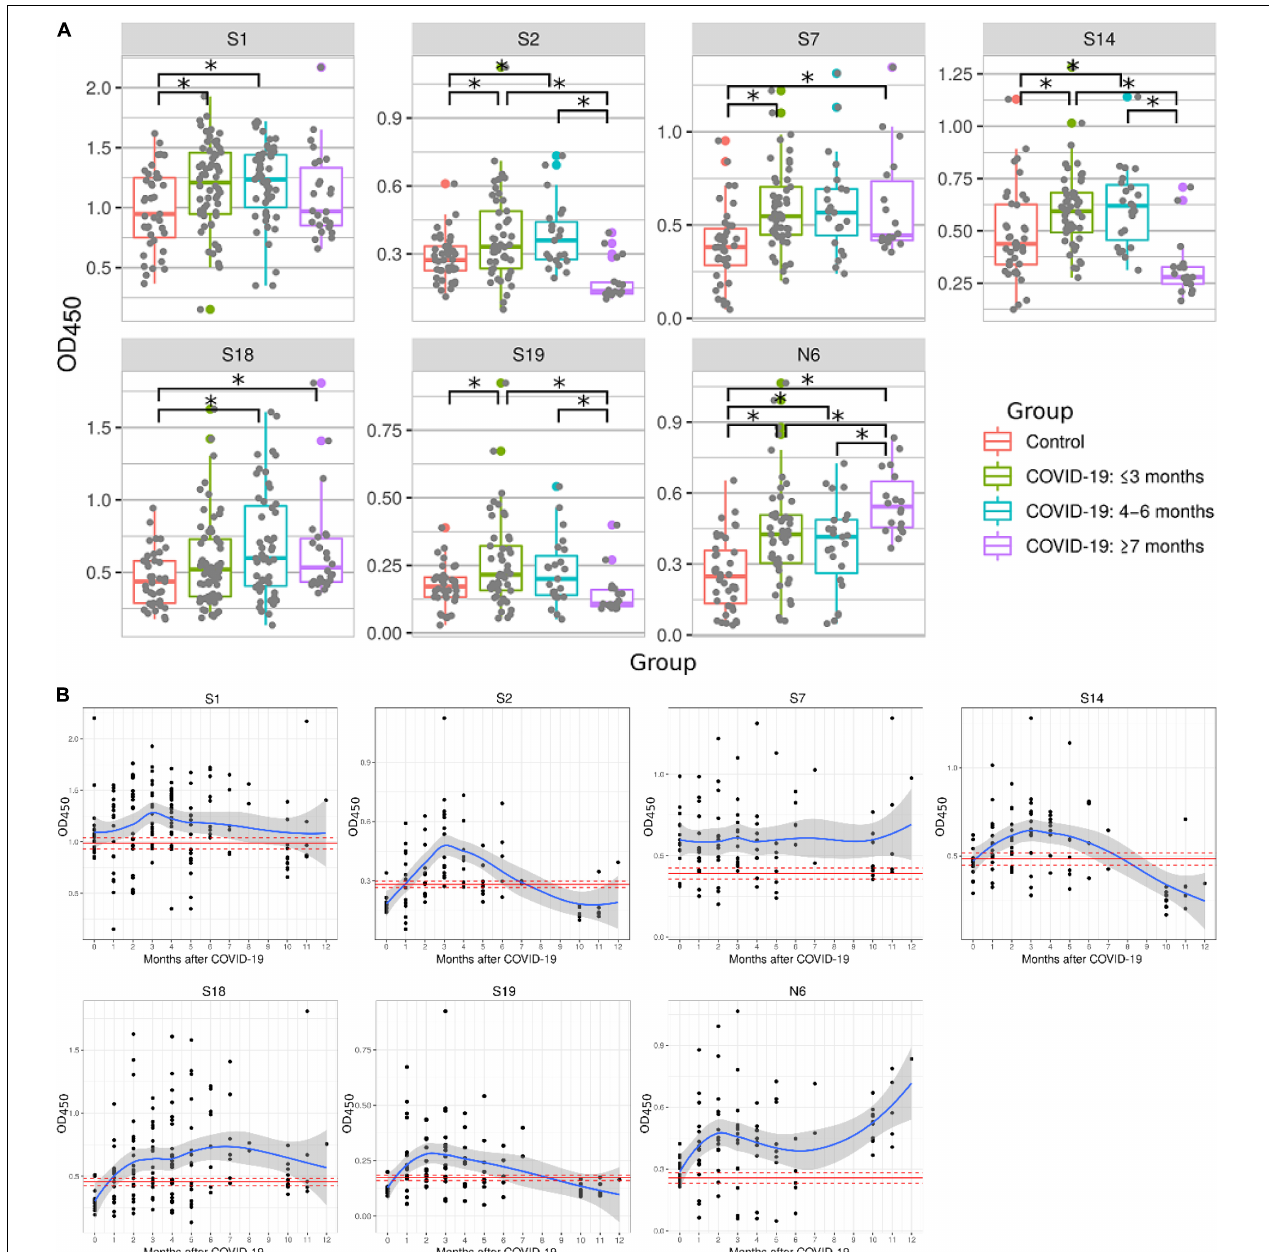
FIGURE 3 | Reactivity of COVID-19 serum samples with SARS-CoV-2 peptides depending on time after convalescence. Antibody reactivity was analyzed using ELISA. Peptides were adsorbed on a 384-well plate and probed with serum samples. (A) Reactivity to SARS-CoV-2 peptides in COVID-19 serum samples grouped as: ≤ 3 months, 4–6 months and ≥ 7 months. Asterisks indicate statistically significant differences between reactivity to SARS-CoV-2 peptides depending on time since infection ( p < 0.05, Kruskal-Wallis test with Benjamini-Hochberg adjustment). (B) Detailed dynamics of COVID-19 antibody reactivity with SARS-CoV-2 peptides. Red line- mean OD 450 value in control; Dotted red line – mean ± standard error of mean of OD 450 values in control; Blue line – local regression line (LOESS) of OD 450 value in COVID-19; Gray area – standard error of mean for LOESS of OD 450 values in